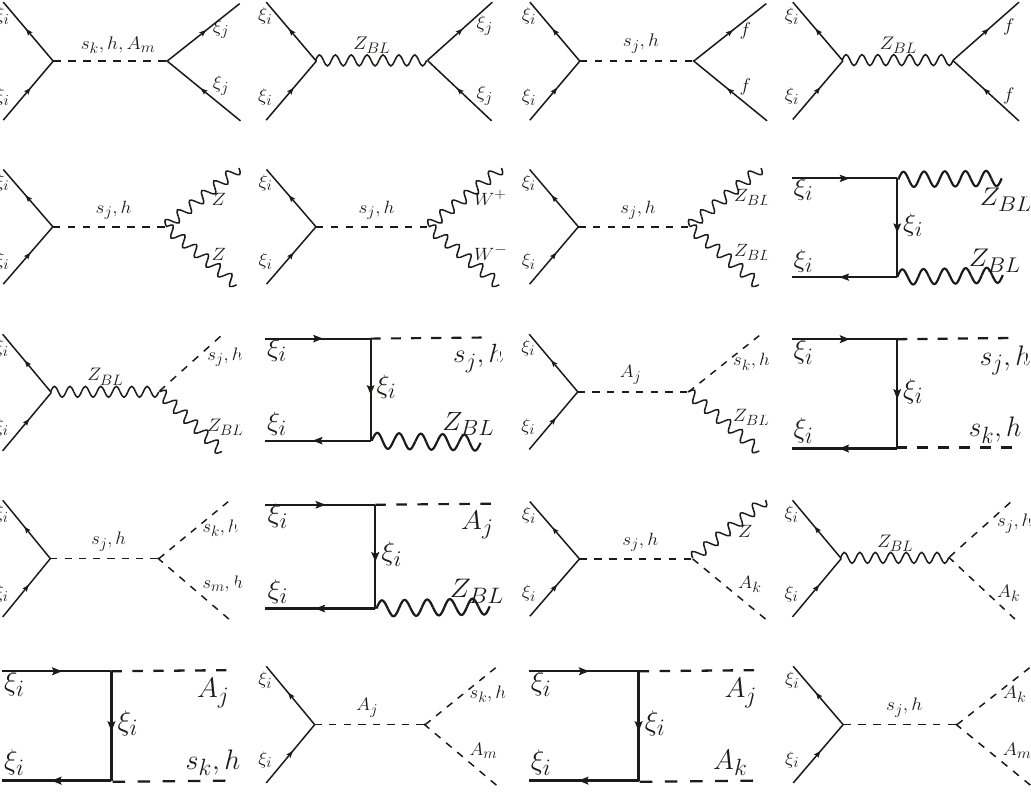
Figure 2 . Feynman diagrams for all possible annihilation channels of two DM